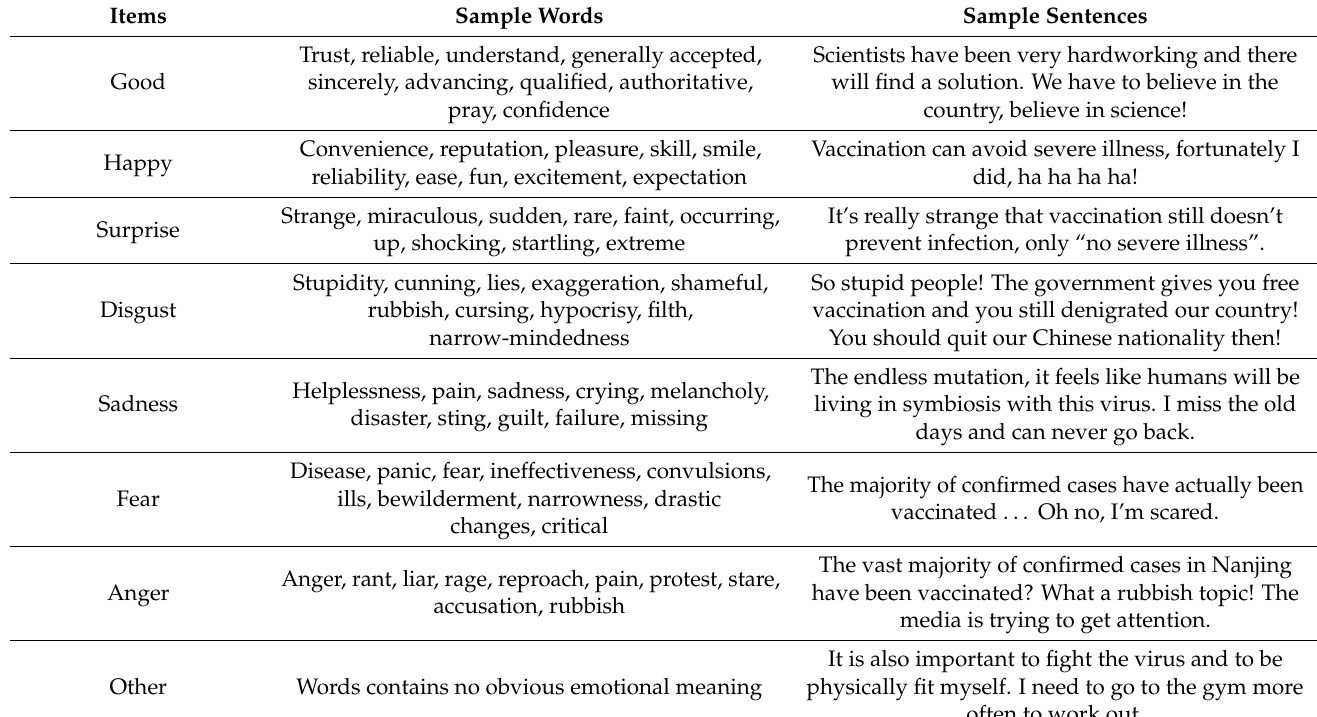
Table 1. Examples of sentiment words and sentiment coding of